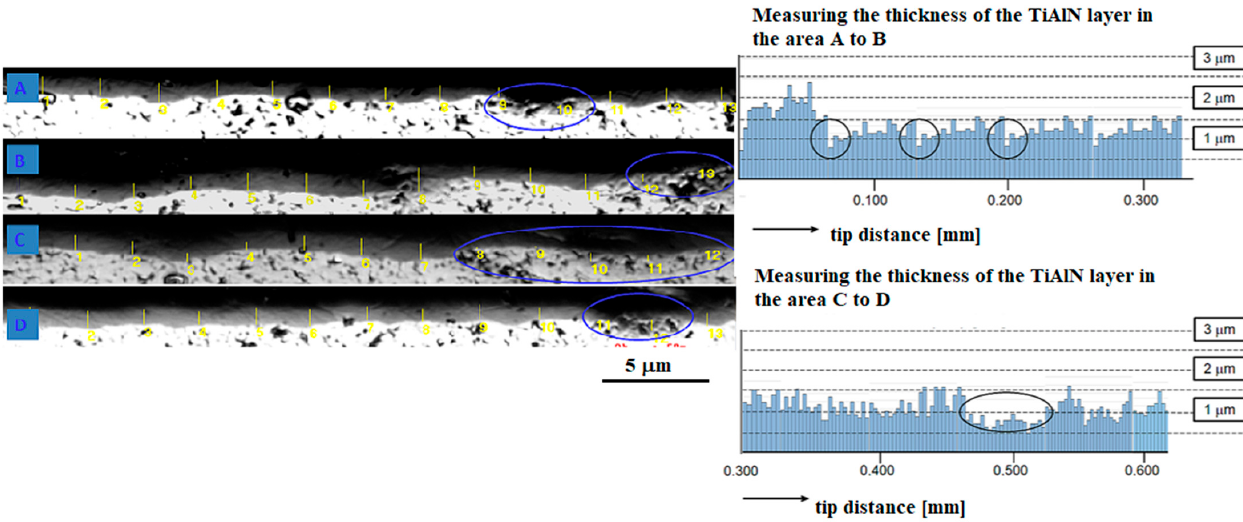
Figure 12. Representation of the thickness of the TiAlN layer of the tool in the measured section—indicating weak points A, B, C, D in the coated layer.